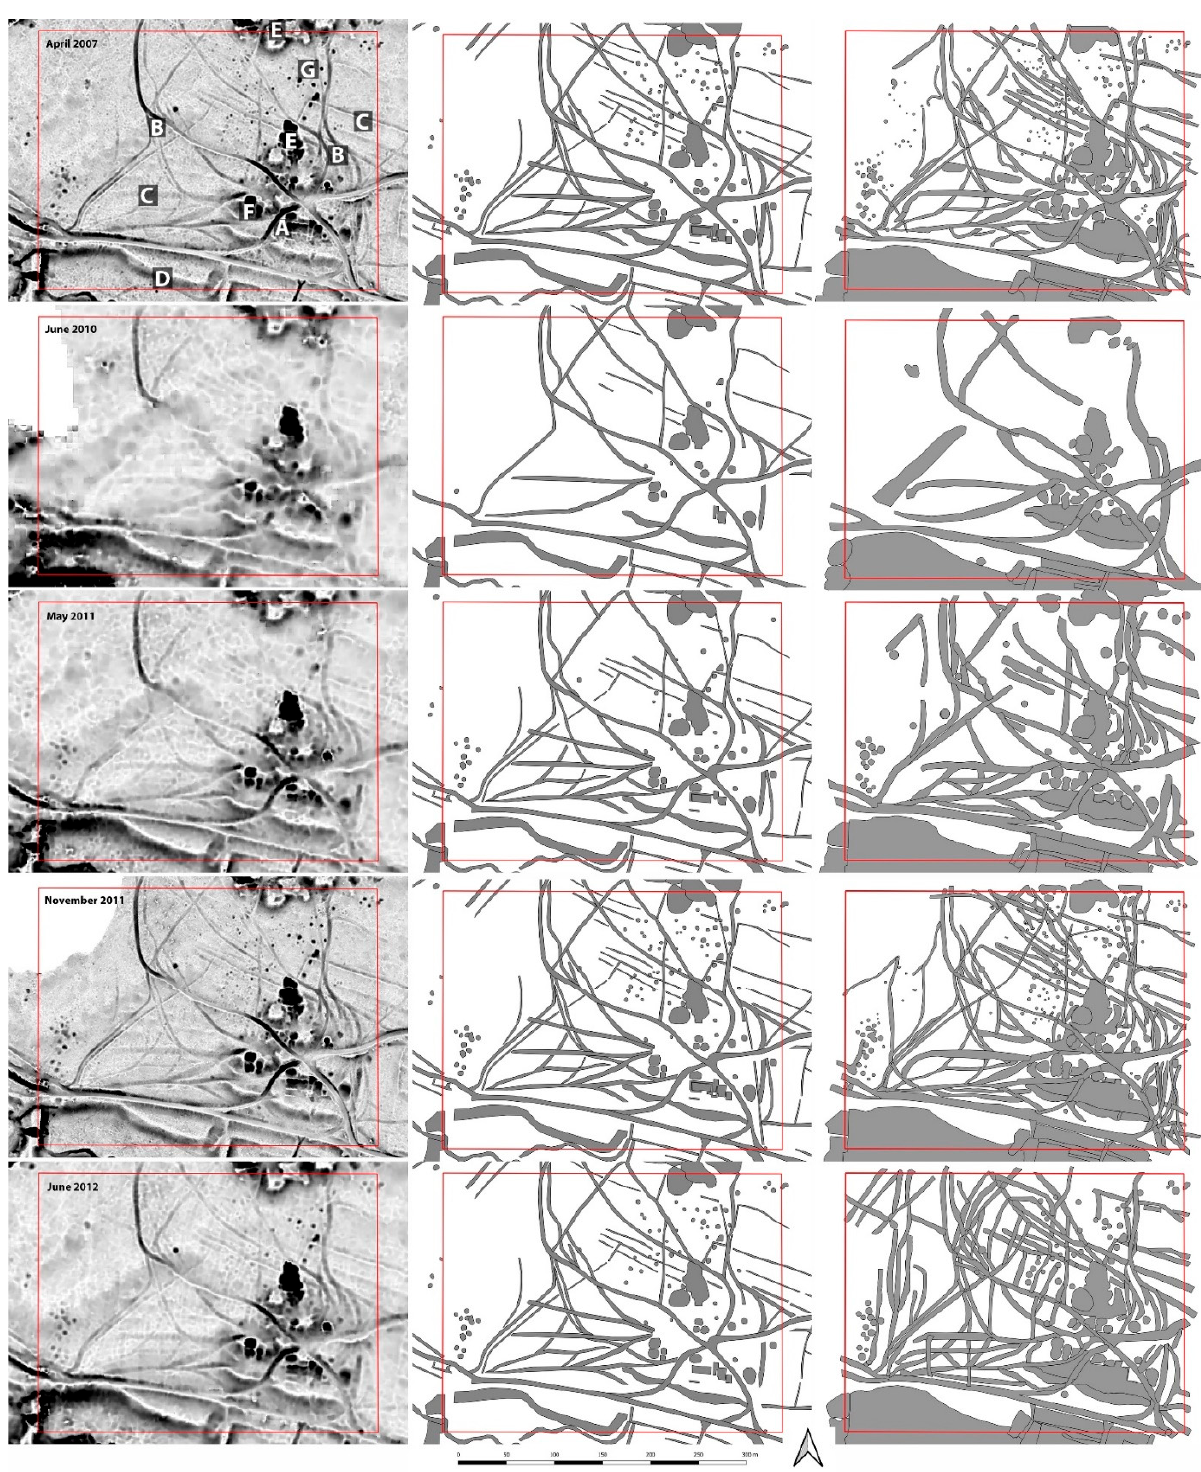
Figure 12. Area 1. The columns represent a visualisation of the dataset using positive openness with colour gradient black to white, stretch to min–max min. 1.41–max. 1.58 ( left ), results of the “copied interpretation” ( centre ), and results of the ”individual interpretation” ( right ). The rows correspond to the individual datasets as indicated for each row in the left image. The red box represents the boundary of the sample area. The letters in the upper left image refer to the text.